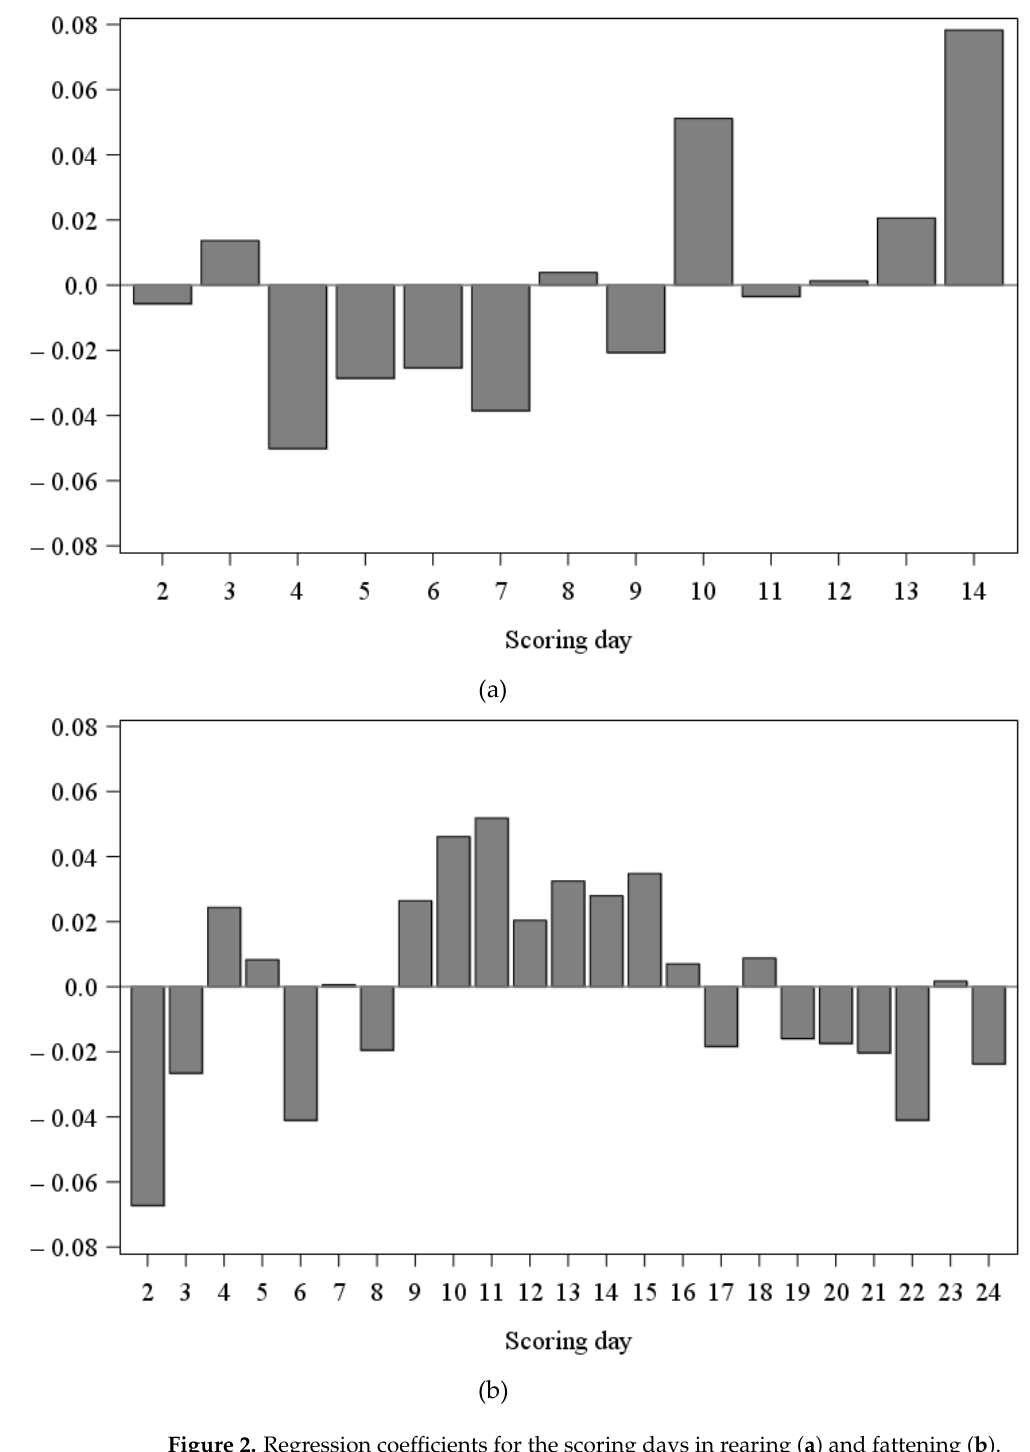
Figure 2. Regression coefficients for the scoring days in rearing ( a ) and fattening ( b ). The results of the PLS regression model without environmental variables are shown in Table 3a). Four PLS factors were extracted which explained 55.5% of the dependent variable’s variance. The directions and strengths of β (scoring days and variables) are comparable between the two PLS regression models for REA. For the direct observation variables and the sensor data variables from pen level, the same variables were selected according to VIP and β. Only treatment index within rearing was not selected according to VIP; water consumption (CV) was selected according to β. Table 3. Variable importance in projection (VIP) and regression coefficient (β) for pen -level and environmental variables collected by direct observation or by using sensors for rearing ( a ) and fat- tening ( b ) and calculated for all variables and without environmental variables. The sensor data variables were tested as mean and coefficient of variation (CV). (a)